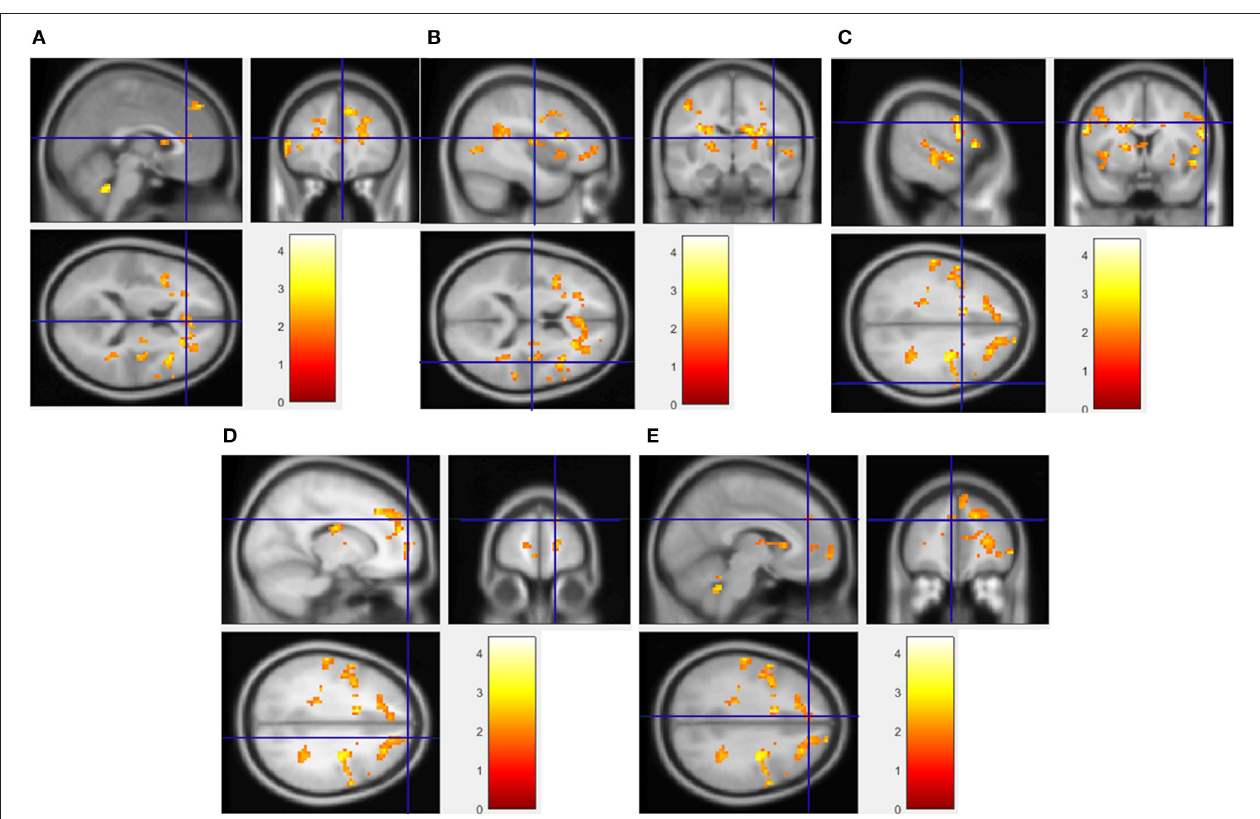
FIGURE 2 | Regions showing significantly greater activation to HF/HS images compared to vegetables. Implicated regions (shown with blue cross-hairs) include the anterior cingulate gyrus (A) , insula (B) , and superior frontal (C) , precentral (D) , and medial frontal gyrus (E) . Activation differences between HF/HCCHO and vegetables are similar (not